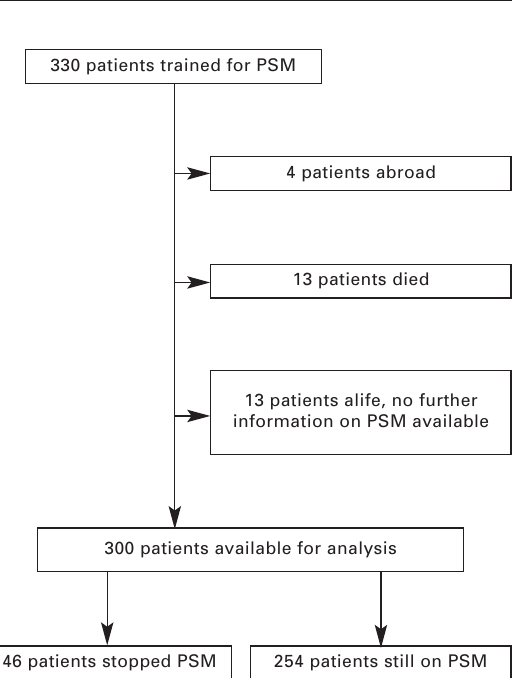
INR, International Normalised Ratio